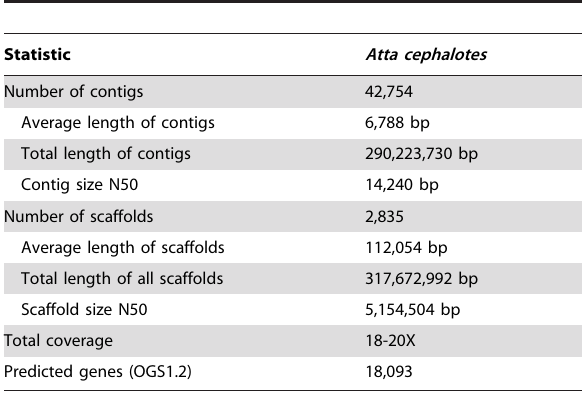
Table 1. General assembly statistics for the genome of the leaf-cutter ant Atta cephalotes